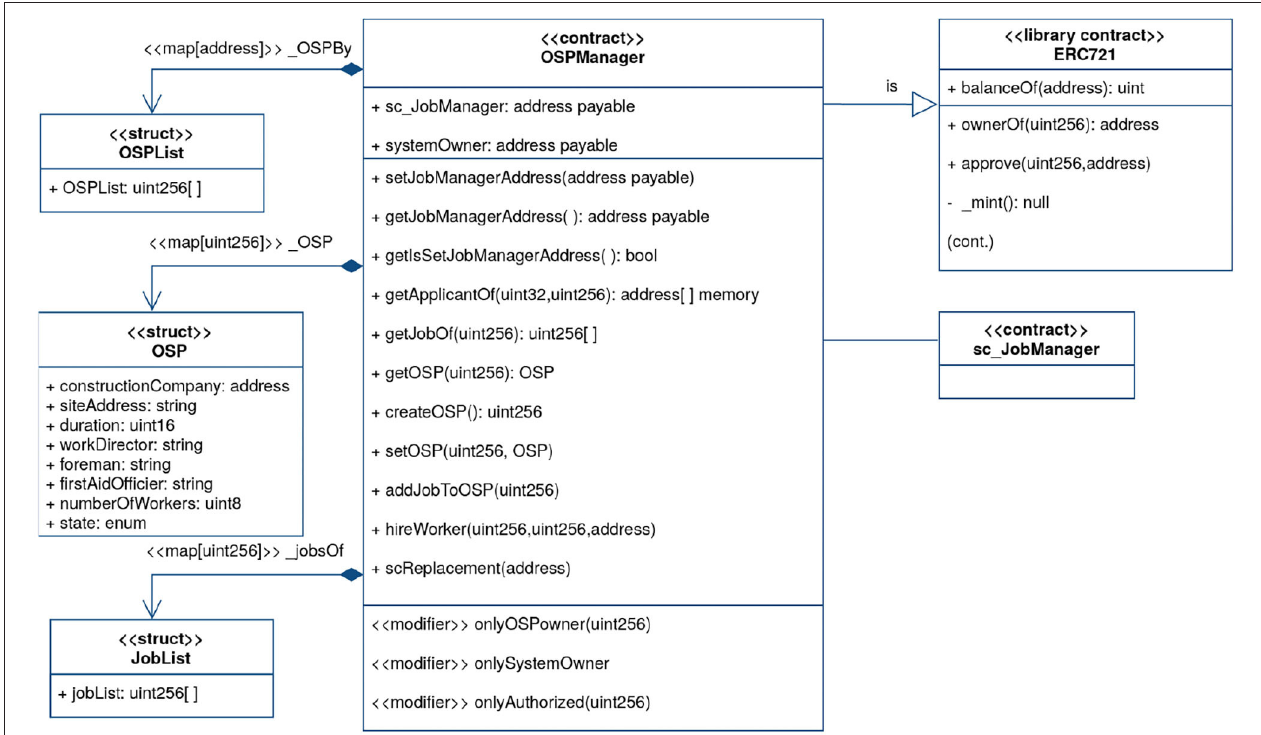
FIGURE 6 | The contract diagram of the smart contract “OSPManager.” This diagram extends the UML Class diagram. Its stereotypes represent the structured data (contract and struct) provided by the Solidity